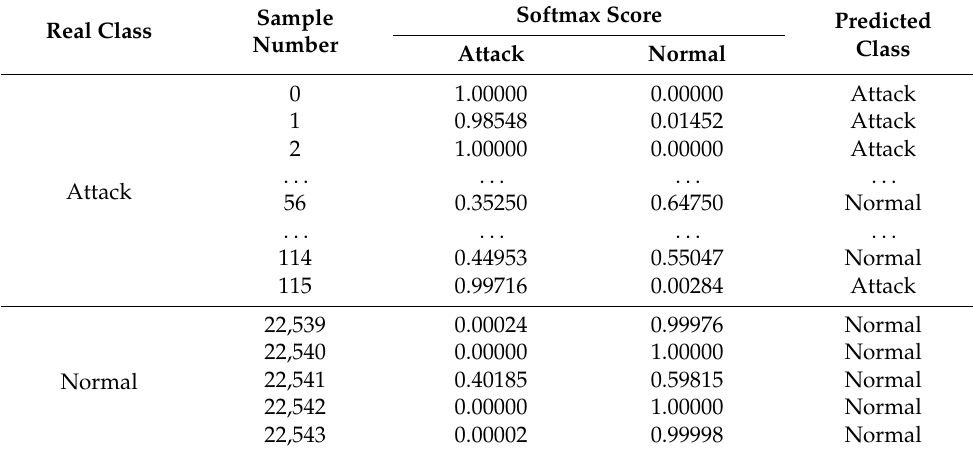
Table 3. The KDDTest+ softmax